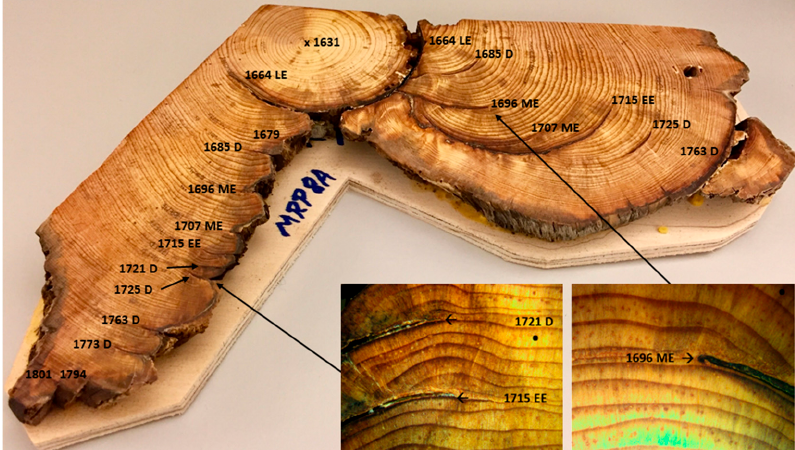
Figure 1. A fire-scarred ponderosa pine cross section from the Middle Rio Pueblo (MRP), Taos Pueblo. The tree survived and recorded 12 fires (1664–1801). The inset images are close-ups of the fire scars, illustrating different intra-annual fire-scar positions, including 1715 early earlywood (EE) and 1721 dormant (D) scars (left) and a 1696 middle earlywood (ME) fire scar (right). The fire-scar positions can be used to infer the timing of past fires. Dormant and early earlywood fires were the most common in the study area, occurring before or during the early growing season (likely May or June).